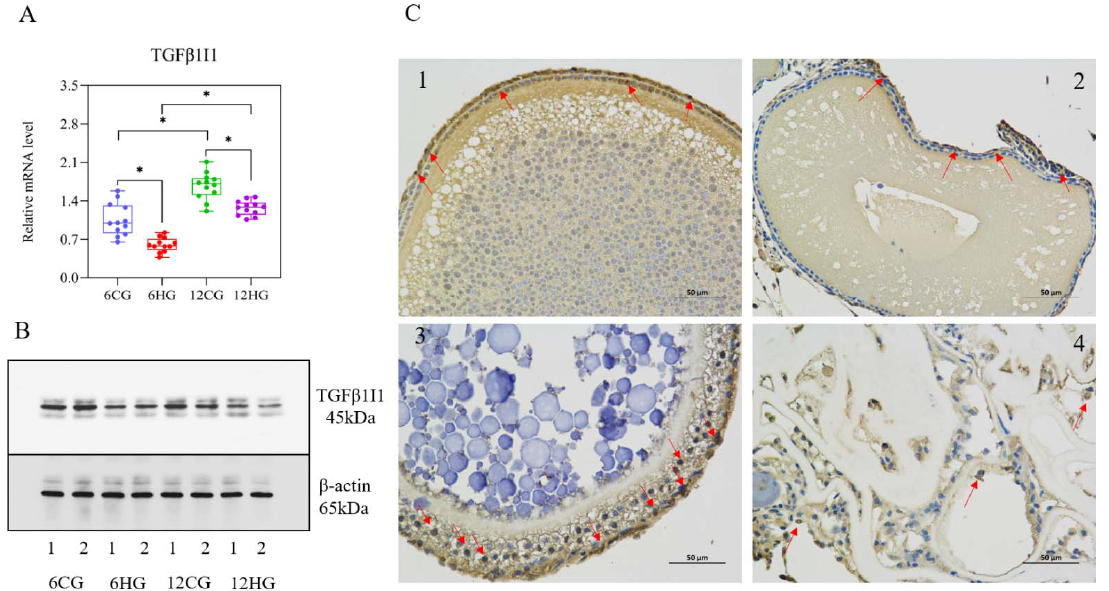
Figure 7. TGF β 1I1 transcript and TGF β 1I1 protein levels, and distribution of TGF β 1I1 protein of Nile tilapia ( Oreochromis niloticus ) ovary under heat stress. Note: ( A ) n = 12. * indicates statistical significance between heat-stressed group and control group ( p < 0.05). ( B ) Representative images of Western blot from female fish in 6CG, 6HG, 12CG, and 12HG. ( C ) 1–4: Red arrow indicates positive expression of TGF β 1I1 protein (scale bar: 50 μ m). Red arrows indicate positive signal of TGF β 1I1 protein. A and C correspond to control group (CG) on days 6 and 12, respectively; B and D correspond to heat-stressed group (HG) on days 6 and 12, respectively.